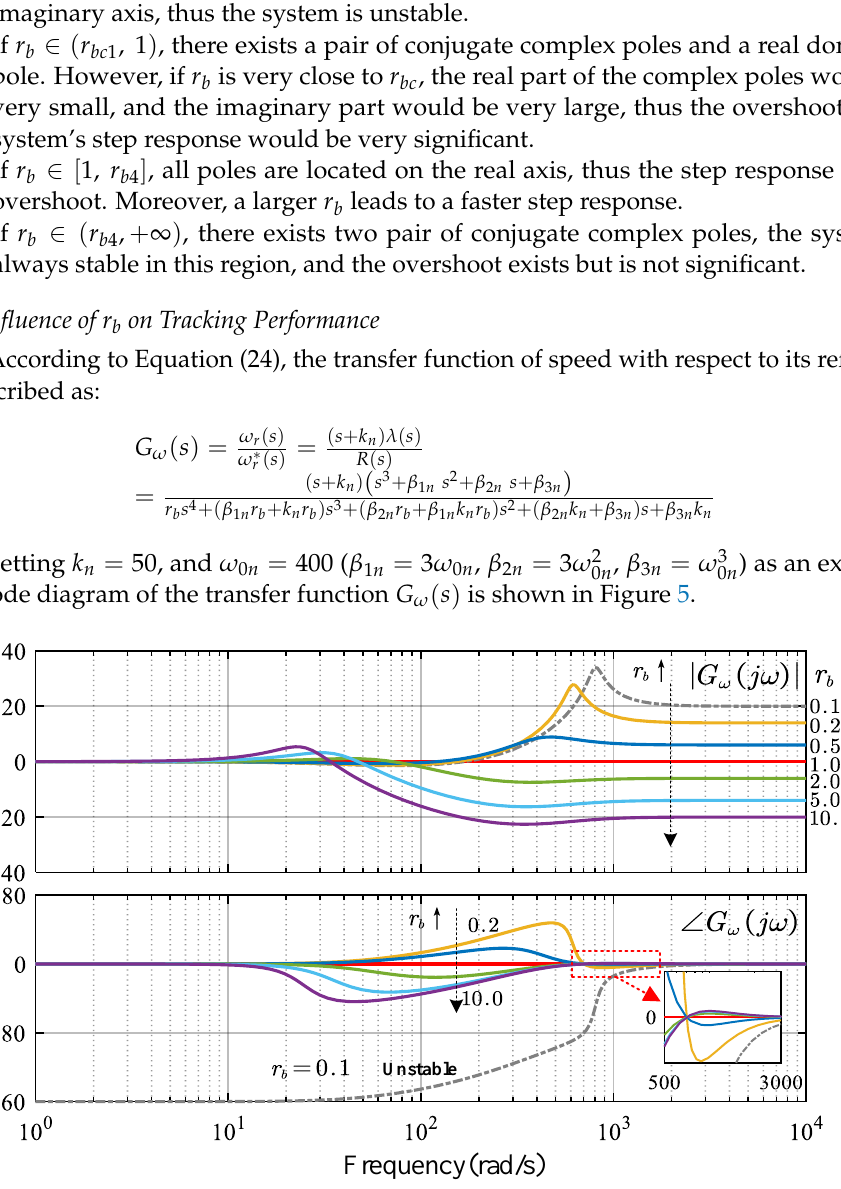
Figure 5. Bode diagram of G ω ( s ) under different r b